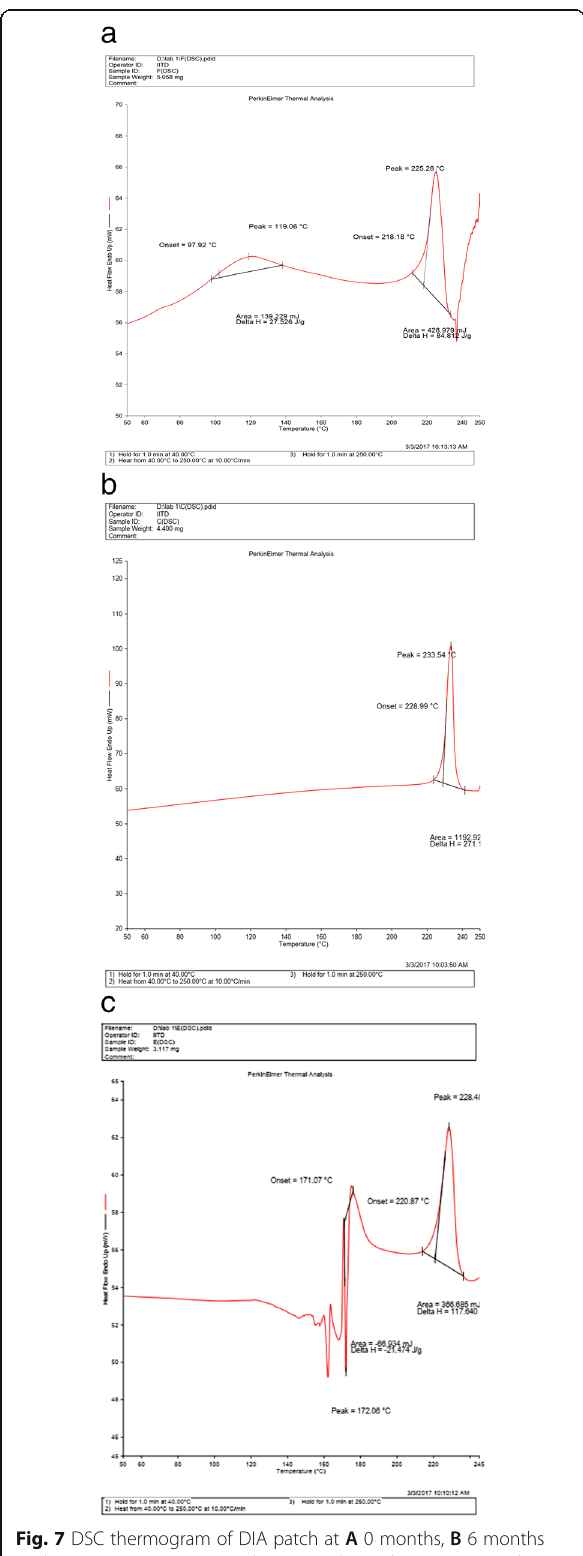
Fig. 7 DSC thermogram of DIA patch at A 0 months, B 6 months under room temperature, and C 6 months under storage